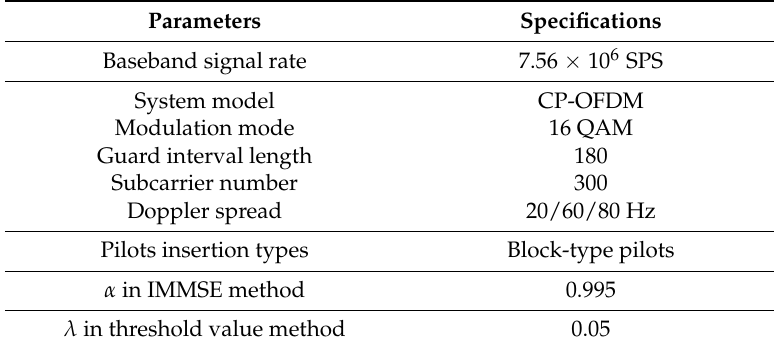
Table 3. Simulation parameters of CP-OFDM systems. SPS: symbols per second; CP: cyclic prefix; OFDM: orthogonal frequency division multiplexing; QAM: quadrature amplitude modulation; IMMSE: improved minimum mean square error.